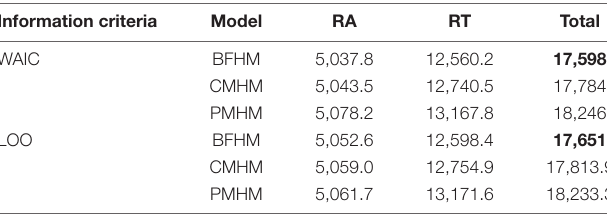
TABLE 2 | The information criteria under the different hierarchical models.